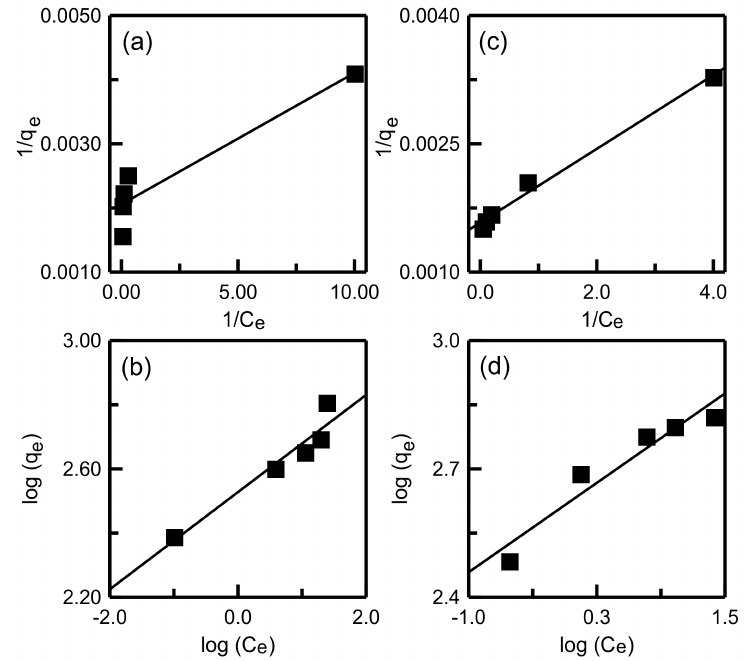
Figure 13. Adsorption isotherms of dye onto adsorbents: Langmuir model for ( a ) RH-SBA-15 and ( c ) RH-GO/SBA-15; Freundlich model for ( b ) RH-SBA-15 and ( d )